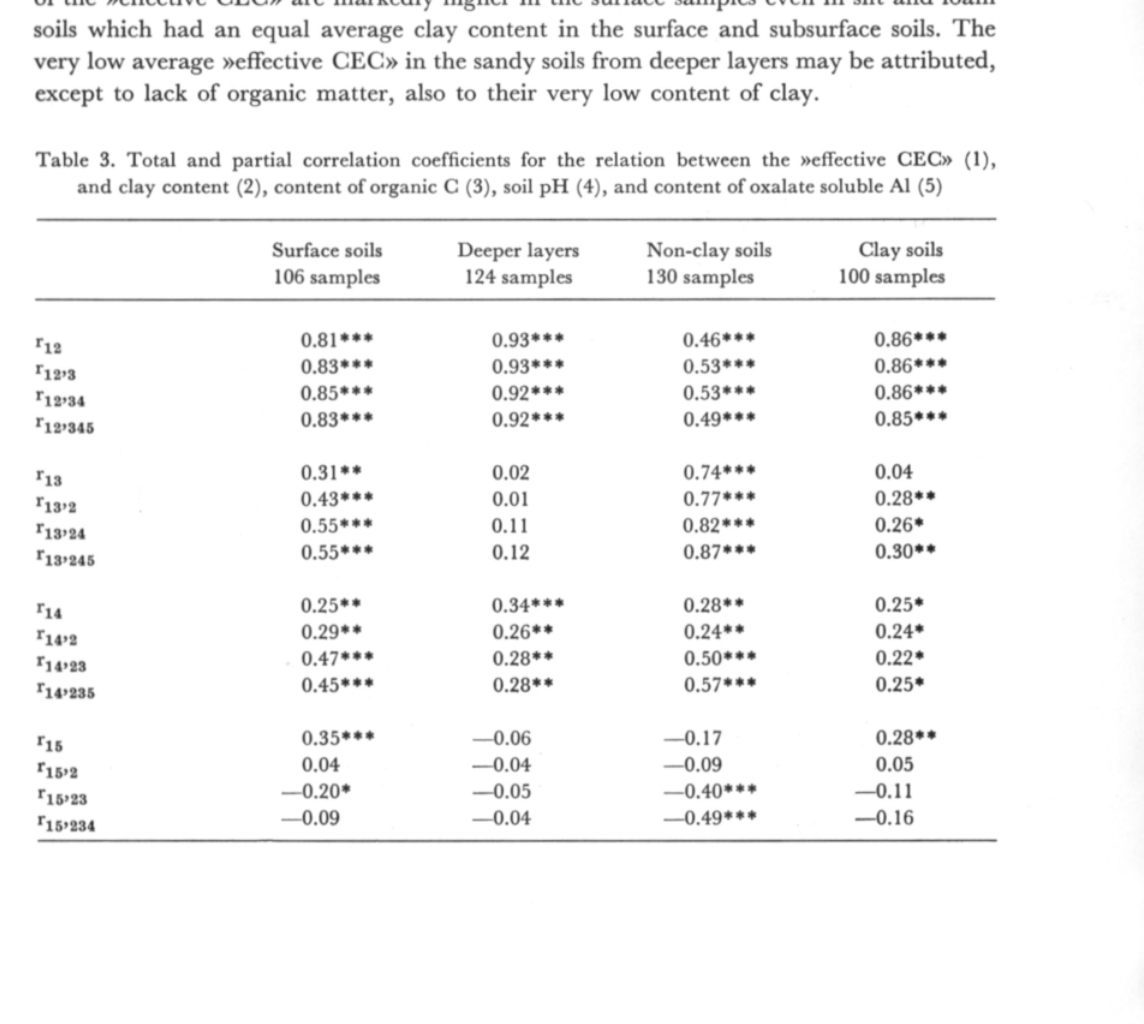
Table 3. Total and partial correlation coefficients for the relation between the »effective CEC» (1), and clay content (2), content of organic C (3), soil pH (4), and content of oxalate soluble A 1 (5) Surface